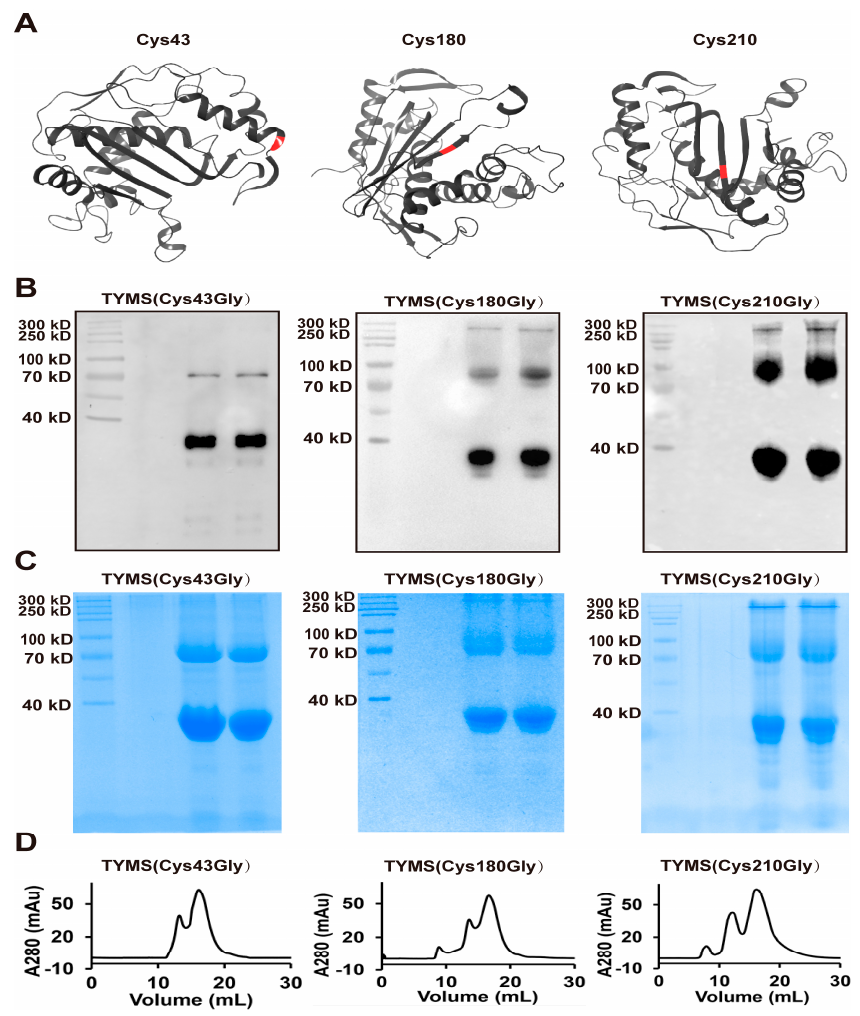
Figure 3. Determination of the oligomeric state of TYMS by mutated Cys. ( A ) Available TYMS structures with Cys43, Cys180, and Cys210 sites depicted as red. The data were derived from PDB (Protein Data Bank) and the ID is 1YPV; ( B , C ) Western blot and Coomassie brilliant blue of TYMS with Cys43Gly, Cys180Gly, or Cys210Gly (without β -mercaptoethanol); ( D ) size exclusion chromatography of TYMS with Cys43Gly, Cys180Gly, or Cys210Gly.